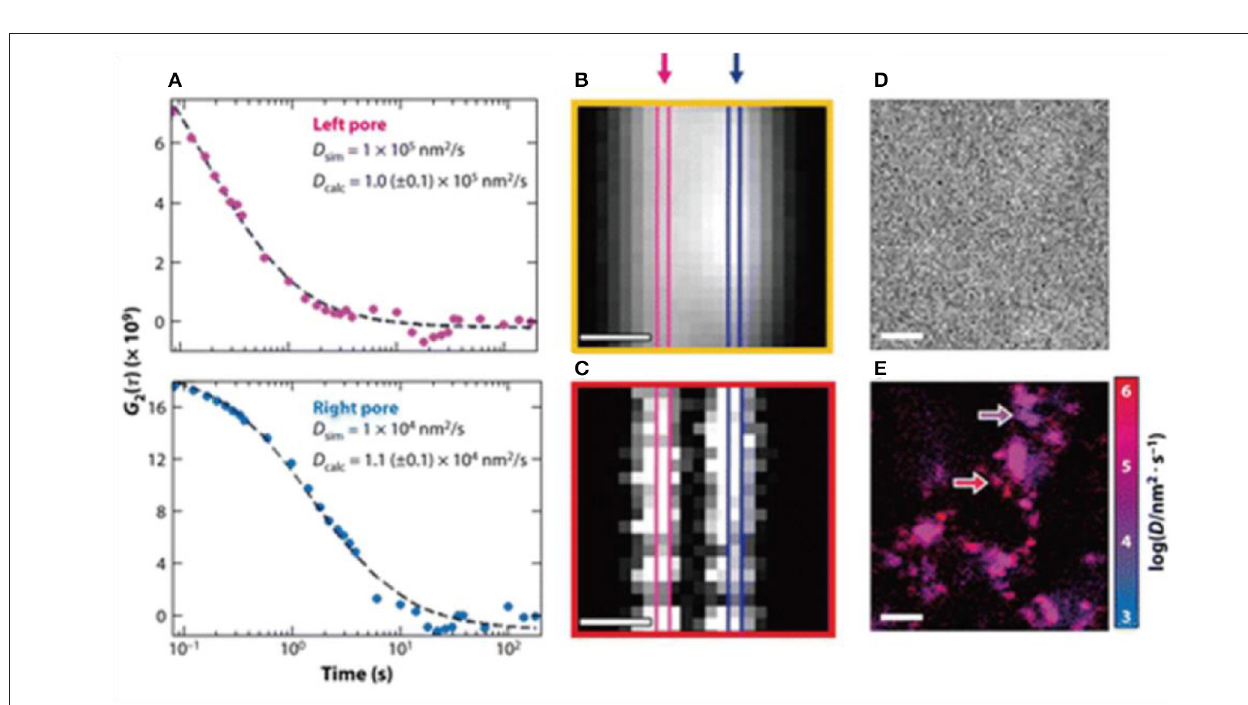
FIGURE 6 | (A–E) Toward predictive protein chromatography via SMLM. It was shown that time resolved super-resolution imaging techniques and combining fluorescence correlation to fluctuation could help build new theoretical frameworks to expand the current understanding of the protein separations in column chromatography. Shown above as an example of using dual mode correlation spectroscopy and fluctuation imaging, so that heterogeneous diffusion behavior of proteins could be resolved and parameters derived (Moringo et al., 2018). Copyright with permission from American Chemical